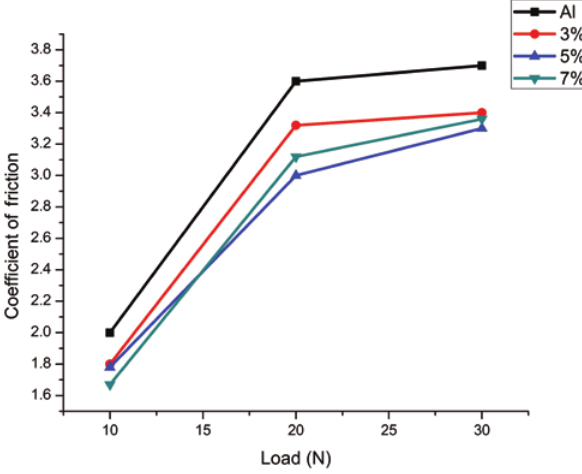
Figure 12: Wear rate of pure Al and cast in situ composite as a function of